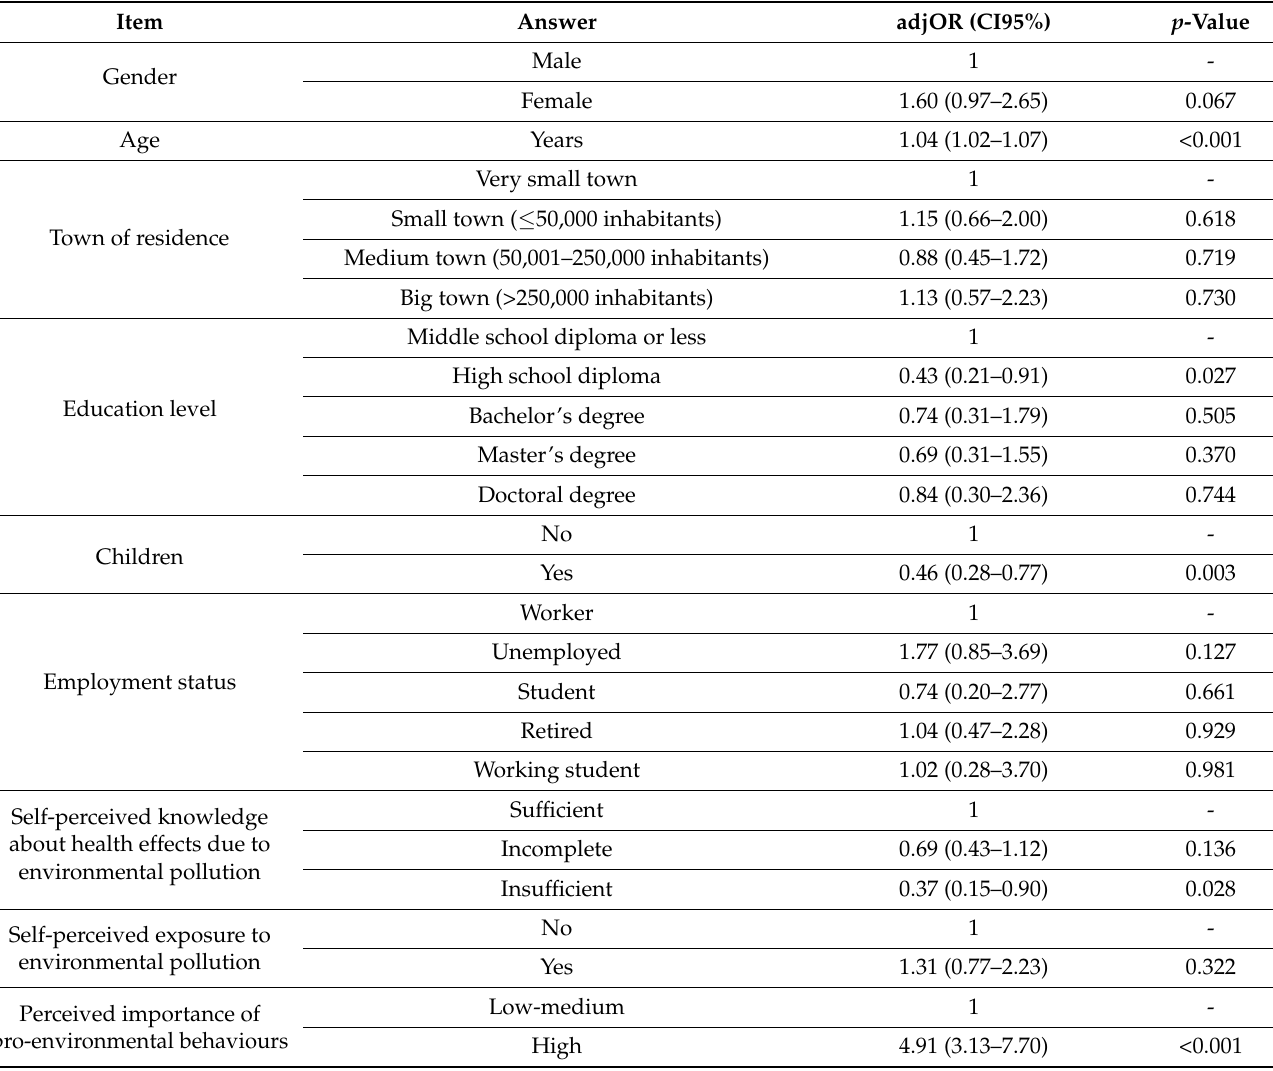
Table 5. Multivariable logistic regression model on the fifth outcome: adoption of pro- environmental